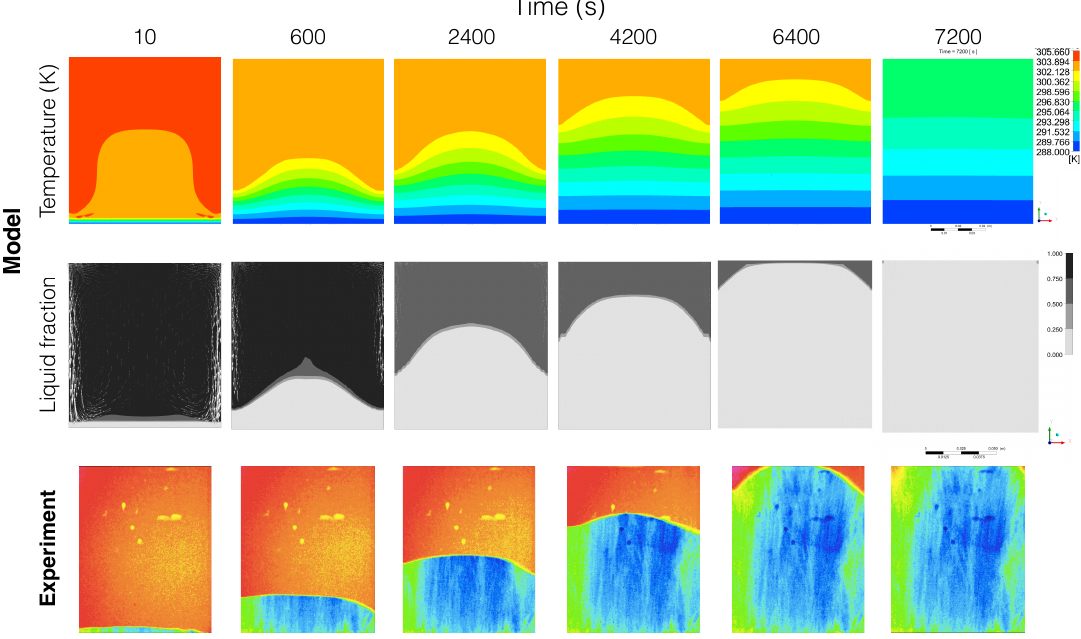
Figure 7. The solidification process dynamics in the presence of a travelling magnetic field. Velocity vectors are superimposed to liquid fraction maps (white arrows). The animation of transient solidification can be found at supplementary data